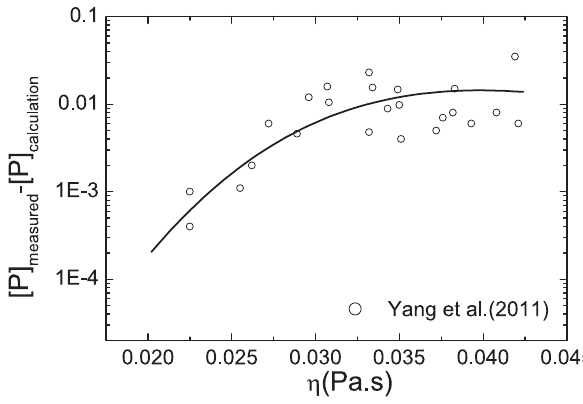
Fig. 13: The correlation of the disequilibrium degree and the slag